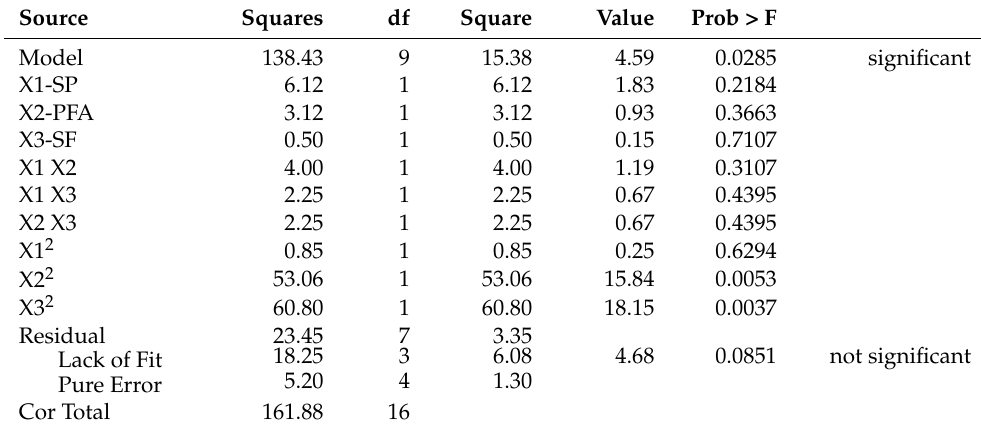
Table 7. Variance analysis of response surface experiments